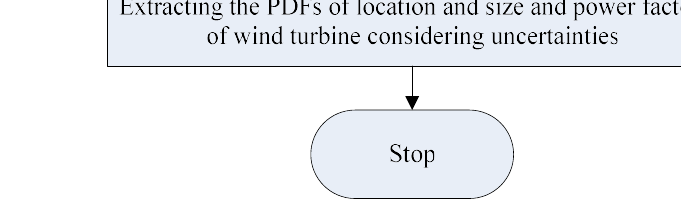
Figure 1. Problem solving flowchart based on the SMM model.